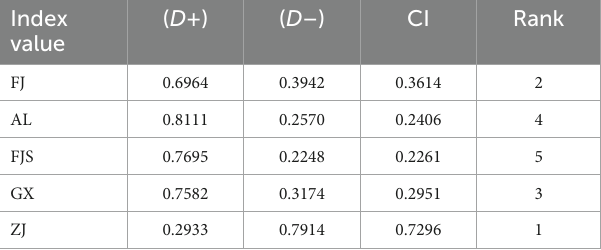
TABLE 6 The Technique for Order Preference by Similarity to Ideal Solution (TOPSIS) evaluation results